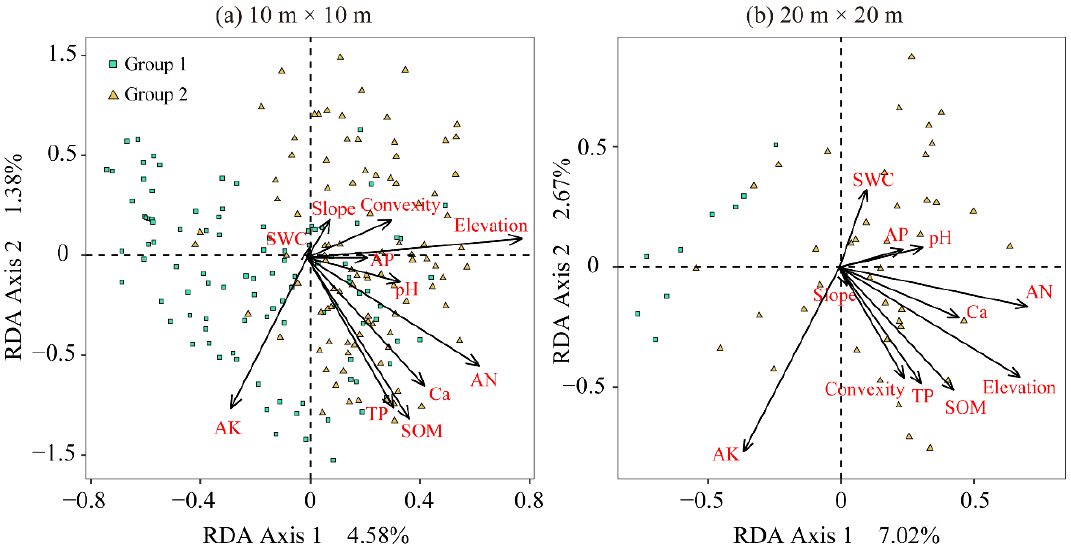
Figure A1. Redundancy analysis RDA ordination diagram for 200 subplots and environmental variables at the 10 m × 10 m sampling scale ( a ) and for 50 subplots and environmental variables at the 20 m × 20 m sampling scale ( b ). The green solid square represents group one, and the solid orange triangle represents group two.